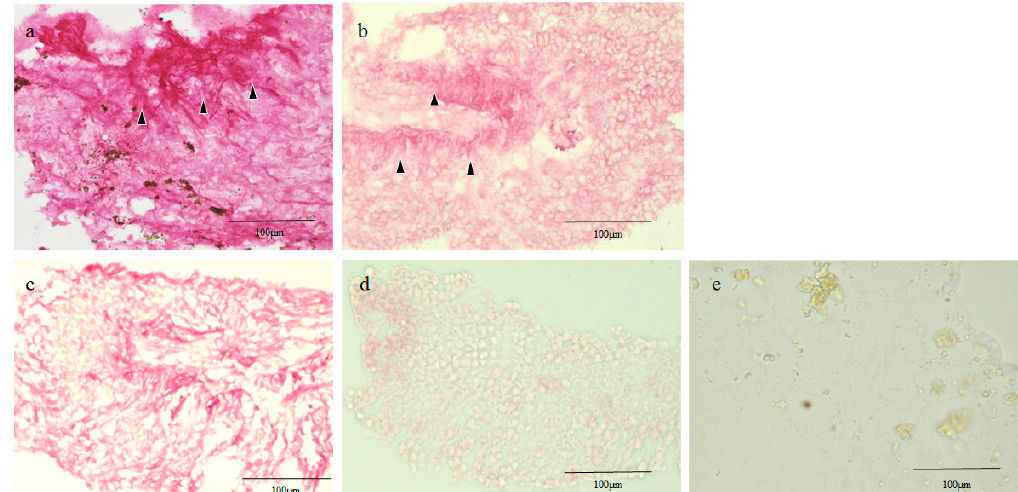
Figure 3. GFAP, RPE65, pan-CK, and CK18 immunostaining of the retinal lattice degeneration whole mount specimen in Case 1. The tissue was stained positive for GFAP, and the central area was slightly more intensely stained (black arrowheads) ( a ). For RPE65, the entire tissue stained positive, while the margins of the central area without nuclei were more intensely stained (black arrowheads) ( b ). For pan-CK, the tissue almost consistently stained positive ( c ), whereas it was little stained with CK18 ( d ). Negative control ( e ).